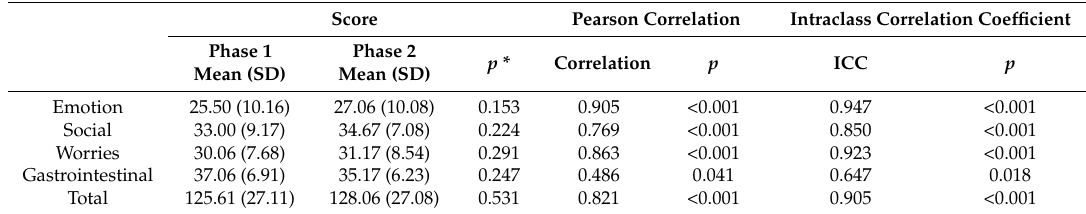
Table 2. CD-QoL scale reproducibility ( n = 18